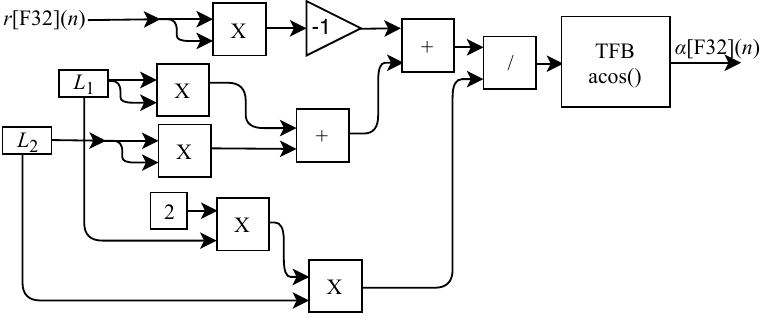
Figure 16. Proposed circuit to perform the calculation of α [ F 32 ]( n ) (Equation (23))—IK-HSD. To complete the process, after performing the calculations of β [ F 32 ]( n ) , γ [ F 32 ]( n )